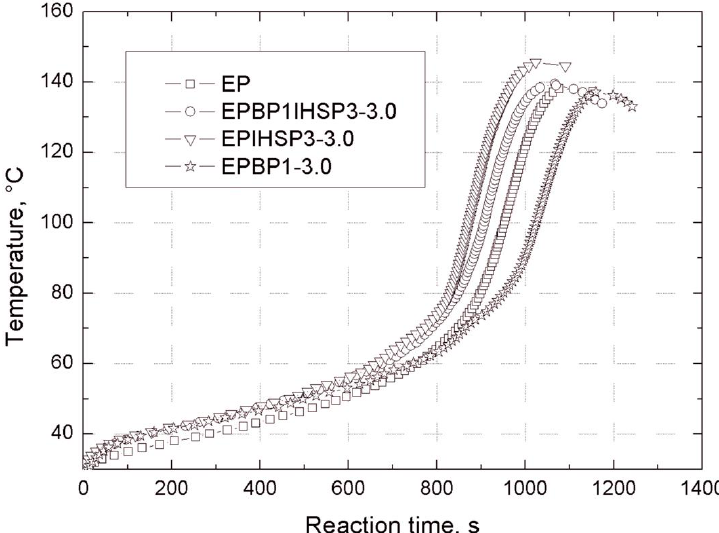
Figure 11. Gelation curves of epoxy resin (EP) and the composites EPPOSS1IHSP3-3.0, EPIHSP3-3.0 and EPBP1-3.0.